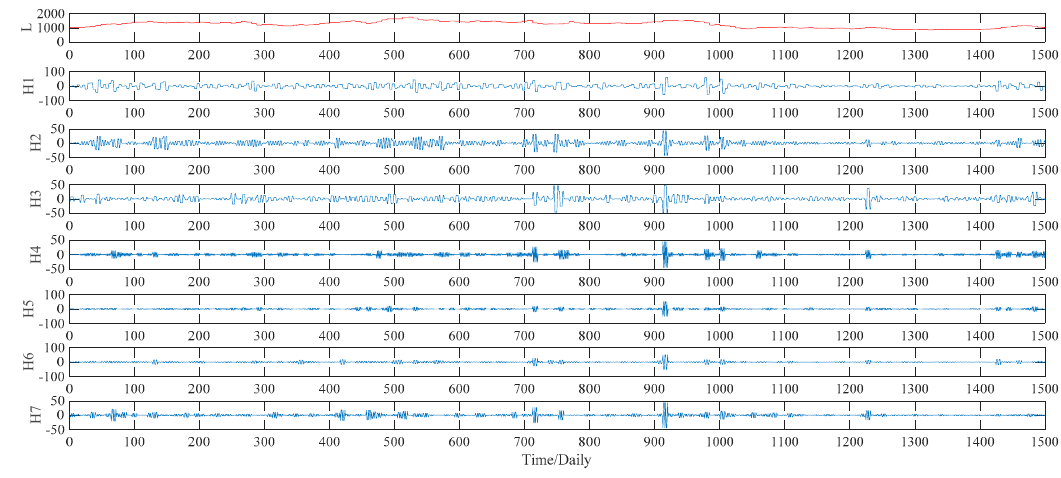
Figure 20. Decomposition results of the WPT method (soybean).